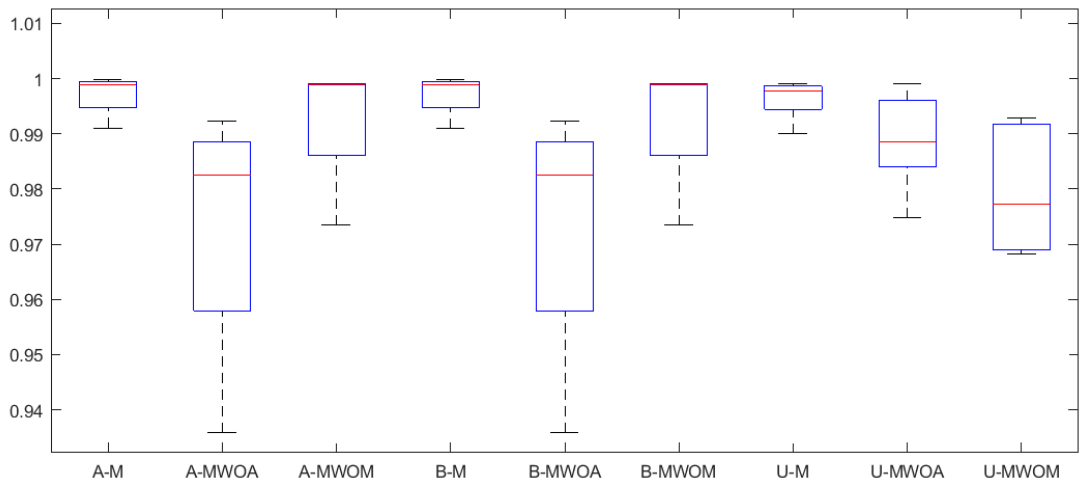
Figure 17. Statistic of AUCs of ROC for di ff erent scenarios. From left to right, the first letter of the box’s name: A, B, U denotes the datasets, i.e., Airport, Beach, and Urban, respectively, followed by M, MWOA, or MWOM which are for the scenarios, i.e., MPAF, MPAF without AF, and MPAF without MP, respectively.